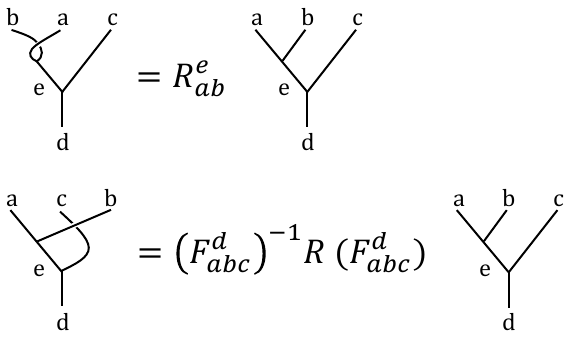
Figure 6: Exchanging anyons in different bases and the R -matrices. When two anyons a and b are exchanged in a basis where they are fused first ( | ( ab ) c ; ec ; d 〉 ), the R -matrix acts as a = e i θ e diagonal matrix that assigns a phase factor R e ab depending on their fusion channel e ab